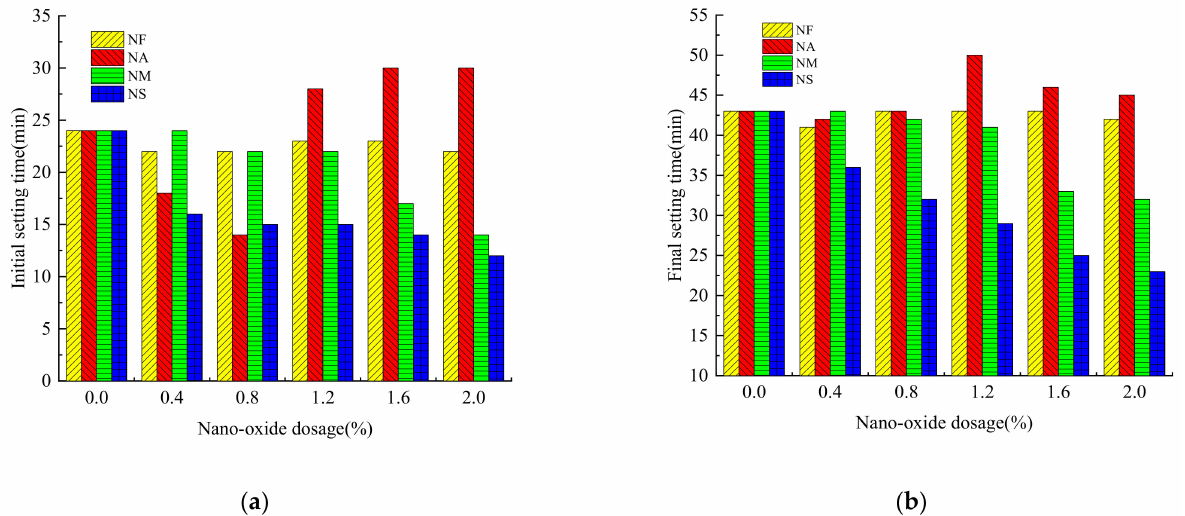
Figure 1. Effect of nano-oxides on setting time of grouting material. ( a ) Initial setting time; ( b ) Final setting time. The meanings of NF, NA, NM, and NS are Nano-Fe 2 O 3 , Nano-Al 2 O 3 , Nano-MgO, and Nano-SiO 2 ,